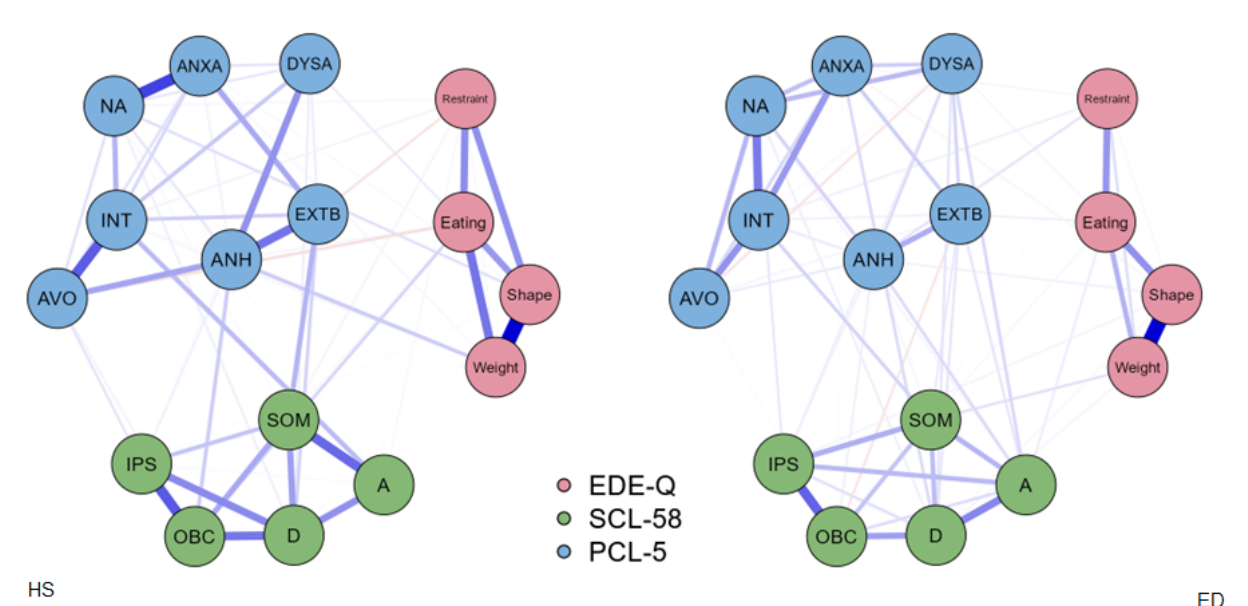
Figure 1. Estimated network structures. The circles represent variables and the lines represent edges (i.e., the association between two variables), and the thicknesses and darkness of lines indicate the weights of the edges. The blue edges indicate positive associations, and the red edges indicate negative associations. Extb: externalizing behavior, anxa: anxious arousal, dysa: dysphoric arousal, anh: anhedonia, na: negative affect, avo: avoidance, int: intrusion, a: anxiety, d: depression, ips: interpersonal sensitivity, obc: obsessive-compulsive, som: somatization, EDE-Q: eating disorder examination questionnaire, SCL-58: symptom checklist-58, PCL-5: PTSD checklist for DSM-5.